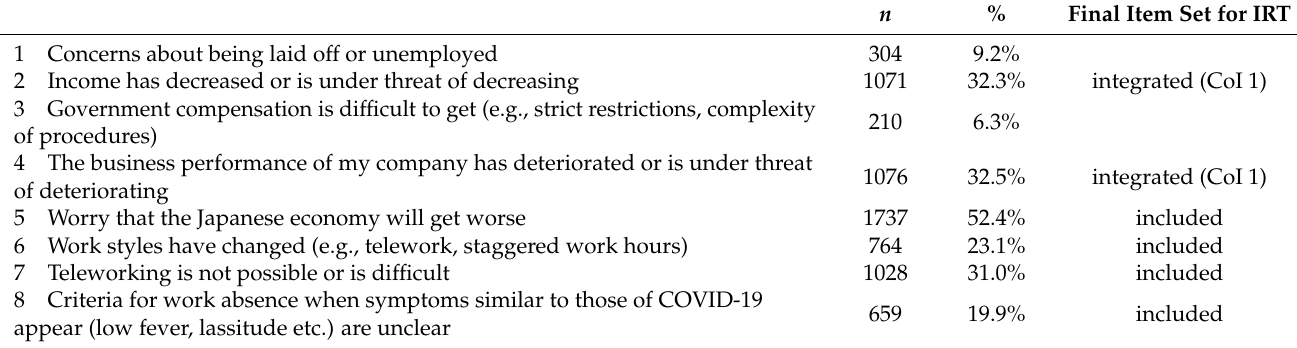
Table 3. Items of COVID-19-related difficulties (CORDI) in this survey.